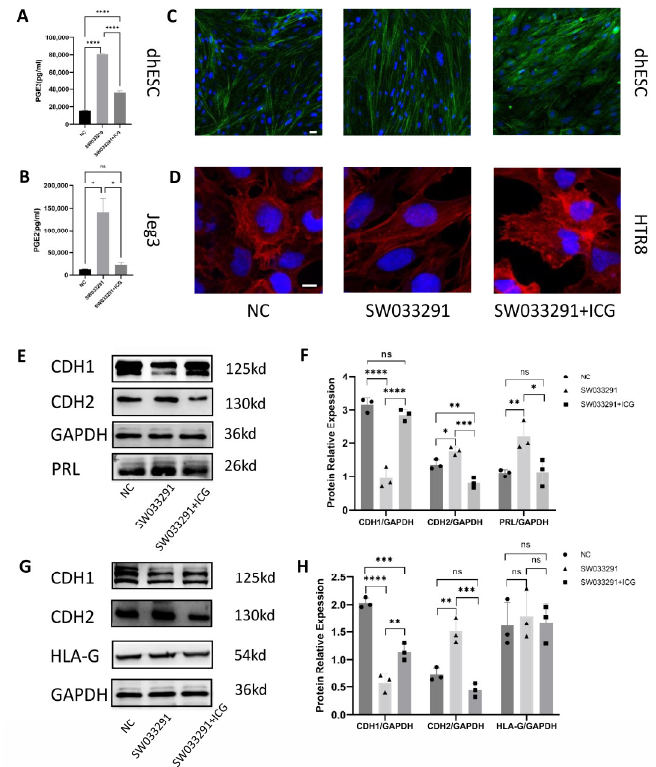
Figure 7. Function of the 15-PGDH inhibitor dependent on PGT. ( A , B ) PGE2 levels in cell lysates were quantified by ELISA. ( A ) represents PGE2 levels in dhESCs; ( B ) represents PGE2 levels in Jeg3 cells. ( C , D ) F-actin staining revealed cytoskeletal changes in dhESCs and HTR8 cells in the NC (normal control) group, SW033291 group, and SW033291+ICG group. Bar= 20 nm. ( E , F ) Western blot assays showed the relative levels of EMT markers and decidualization markers. ( G , H ) Western blot assays showed the relative levels of EMT markers and HLA-G. Each experiment was independently performed three times. GAPDH served as a loading control. Band intensities were quantified and normalized to the GAPDH values. The results are representative of at least three independent experiments. * p < 0.05; ** p < 0.01; *** p < 0.001; **** p < 0.0001; ns, not significant (one-way ANOVA). NC: normal control; ICG: indocyanine green; NP: normal pregnancy; PE: preeclampsia.